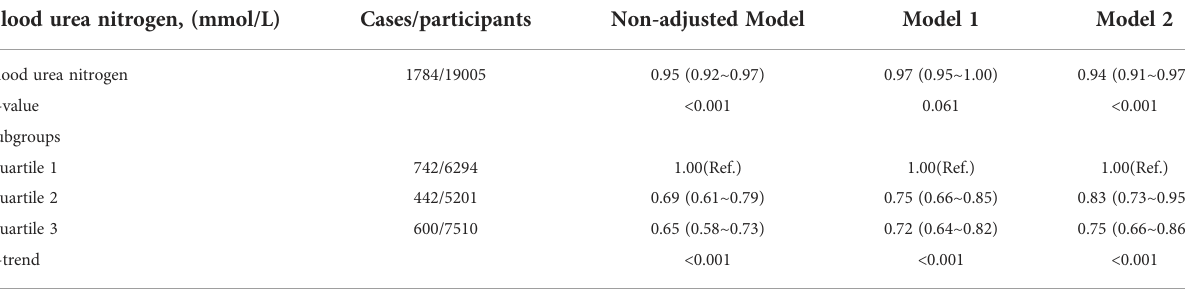
TABLE 3 Weighted odds ratios (95% con fi dence intervals) of depression and different blood urea nitrogen in different